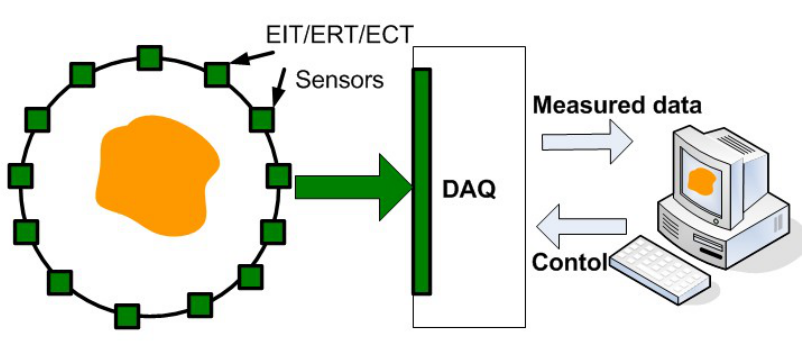
Figure 11. Typical ECT system with an eight electrode sensor, with sensing field boundaries shown.